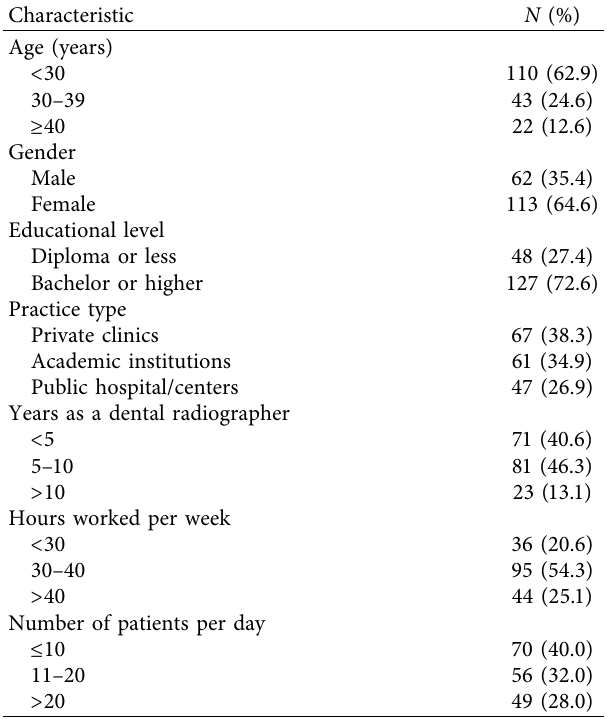
Table 1: Demographic and professional characteristics of study participants ( N �